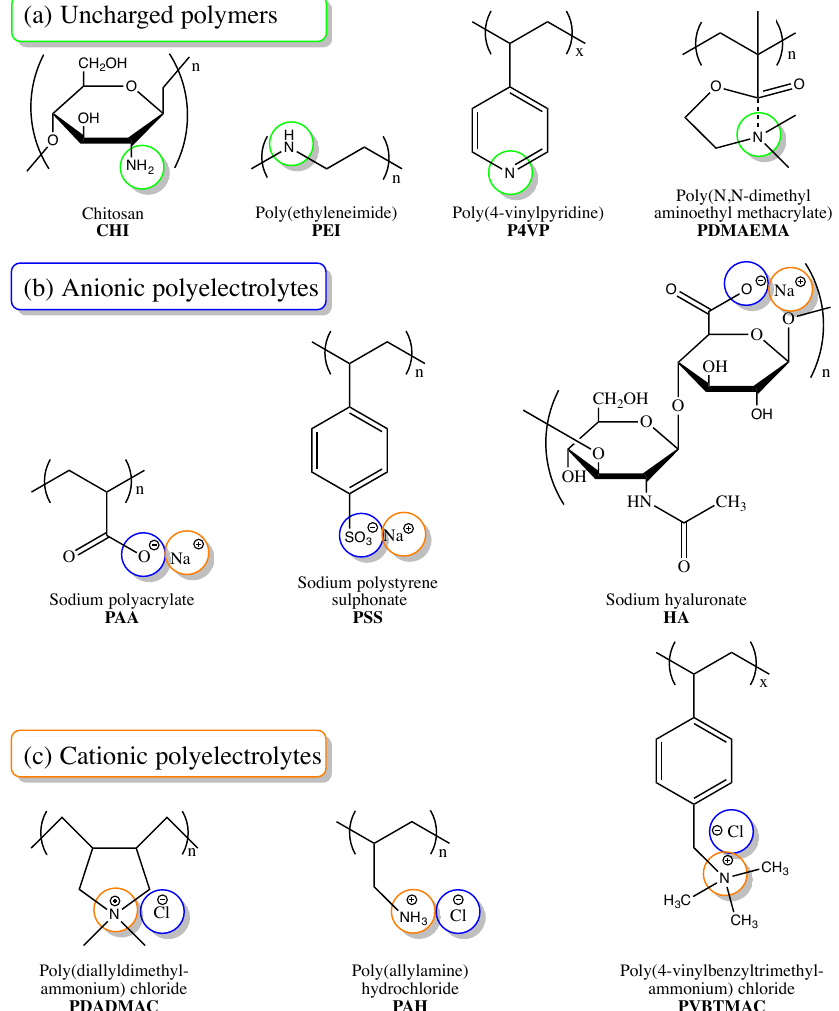
Figure 4. Chemical structures of polymers and polyelectrolytes used as precursors for post-synthetic material modification in membrane-based CO 2